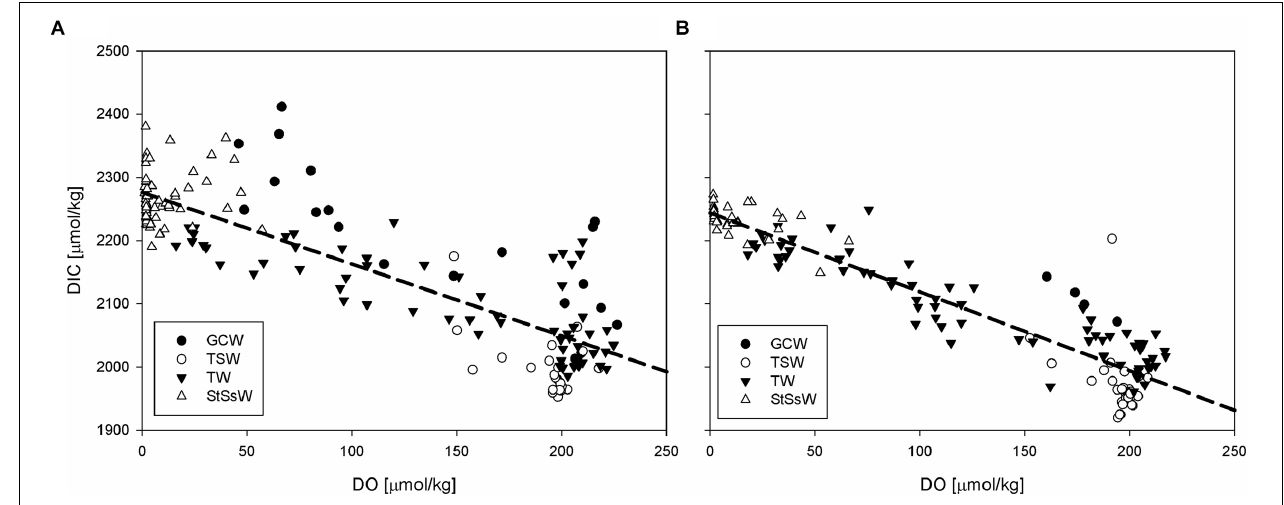
FIGURE 7 | Comparison between dissolved oxygen (DO, µ mol/kg) and dissolved inorganic carbon (DIC, µ mol/kg).The acronyms utilized are Gulf of California Water (GCW), California Current Water (CCW), Transitional Water (TW), Tropical Surface Water (TSW), and Subtropical Subsuperficial Water (StSsW). (A) June 2015, (B) March